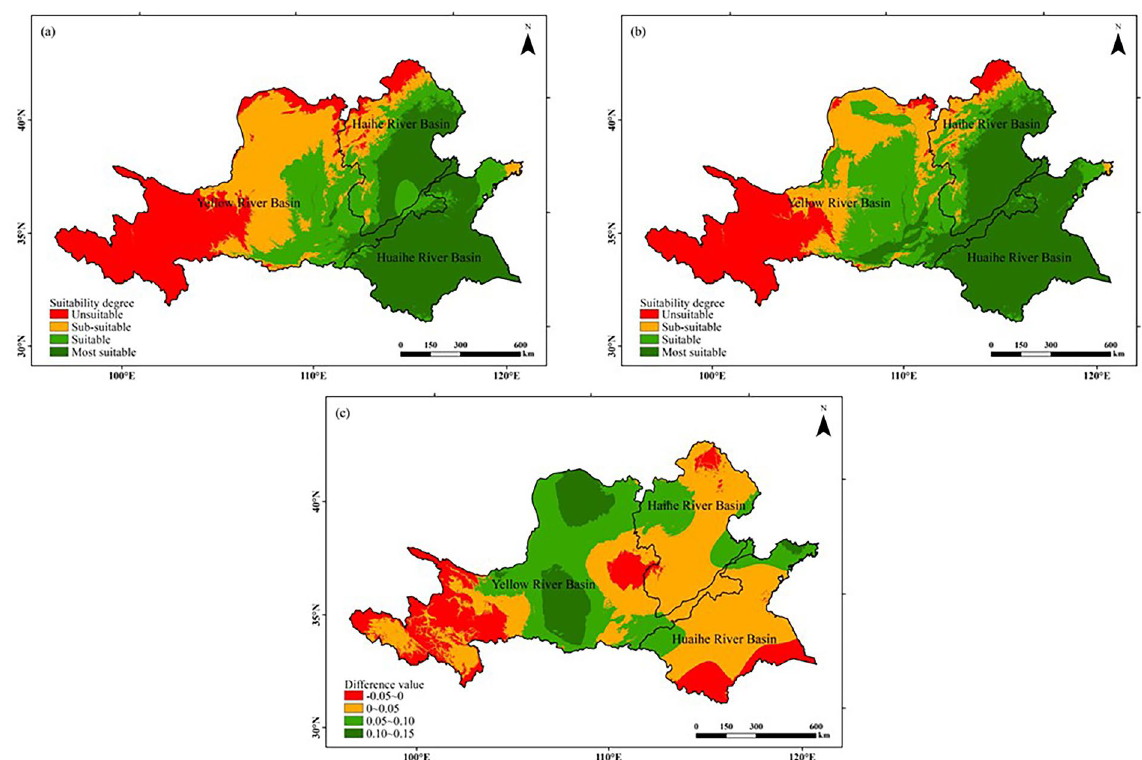
Figure 9. Comparison of comprehensive suitability distribution of peanut growing season in Huang-Huai-Hai region in two climatic years: ( a ) 1960–1989; ( b ) 1990–2019; ( c ) ( b )–( a ). The figure was made in the ArcGIS 10.2 platform (https:// www. esri. com/ en- us/ home).